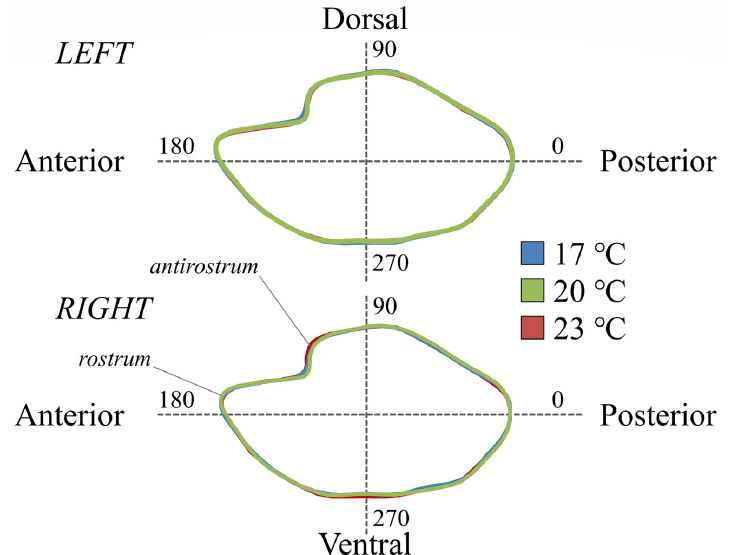
Figure 5. Average otolith shape configurations of seabream early juveniles (93–95 days post-hatching, dph) demonstrate the main shape differences between thermal groups; 17, 20, and 23: fish initially reared at 17, 20, and 23 ◦ C DT (developmental temperature),